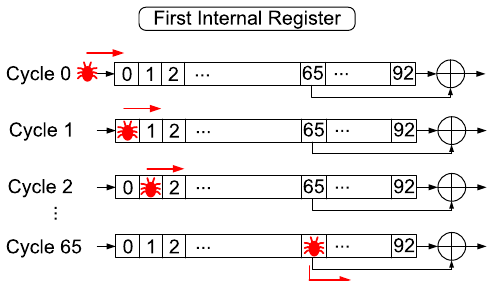
Figure 6. Propagation of the injected fault through the first